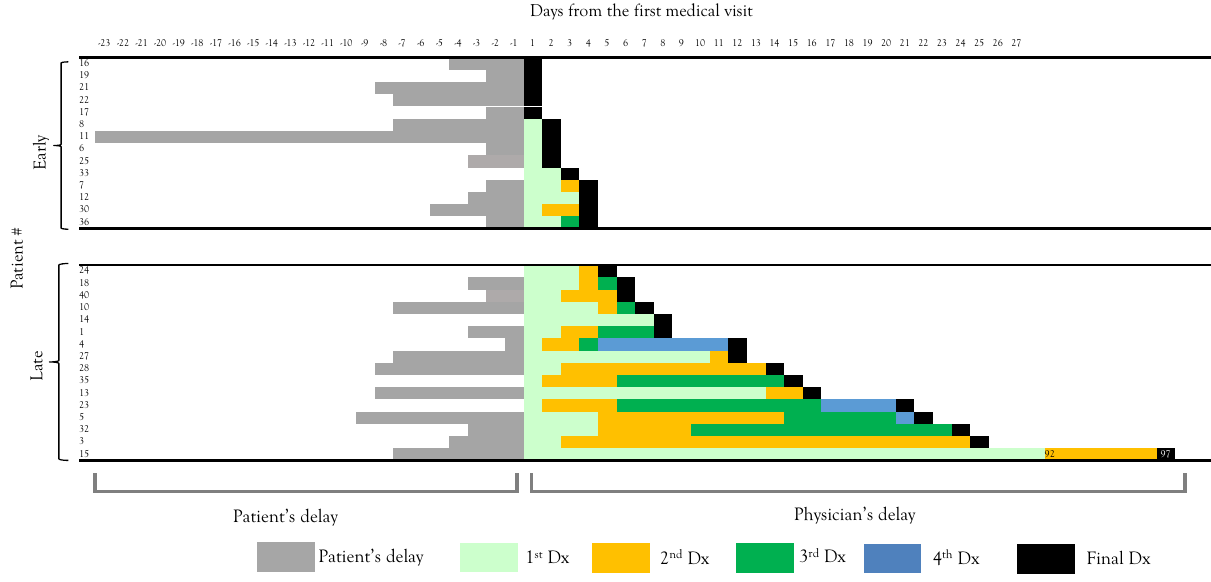
Figure 3. Physicians’ diagnostic delay in paediatric ADEM. Each column shows the diagnostic odyssey plot for each ADEM case. Cases are placed in ascending order of their physician’s diagnostic delay. Physicians’ early- diagnosed cases are those diagnosed ≤ 4 days after initial visit. ADEM acute disseminated